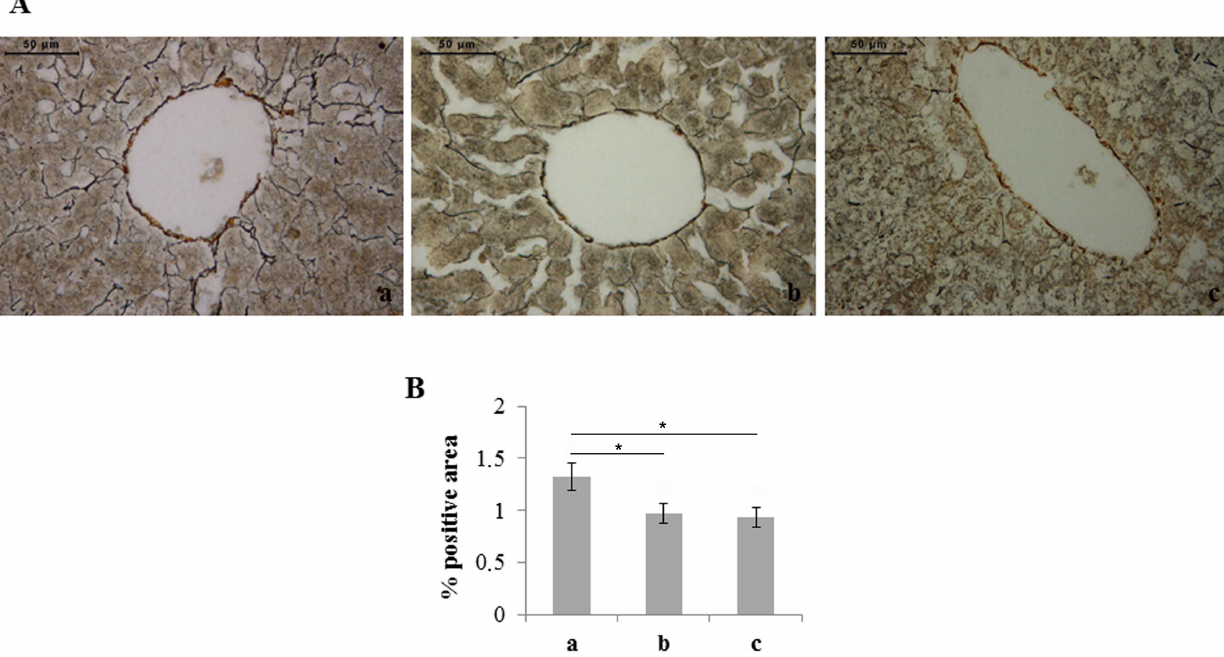
Figure 3. Moderate and severe hyperoxia reduces the amount of reticular fibers in rat liver. A) Silver staining of neonatal rat livers exposed to moderate and severe hyperoxia. Reticular fibers are labeled by black stain. In livers of rats exposed to moderate and severe hyperoxia a lower amount of reticular fibers is visible. a) ambient air; b) 60% hyperoxia; c) 95% hyperoxia. Scale bar: 50 m m, magnification 40x. B) Graphic representation of the percentage area of reticular fibers ( 6 SD); densitometric analysis determined by quantifying thresholded area for black color in ten fields for each of three slides per sample. *=p , 0.05.